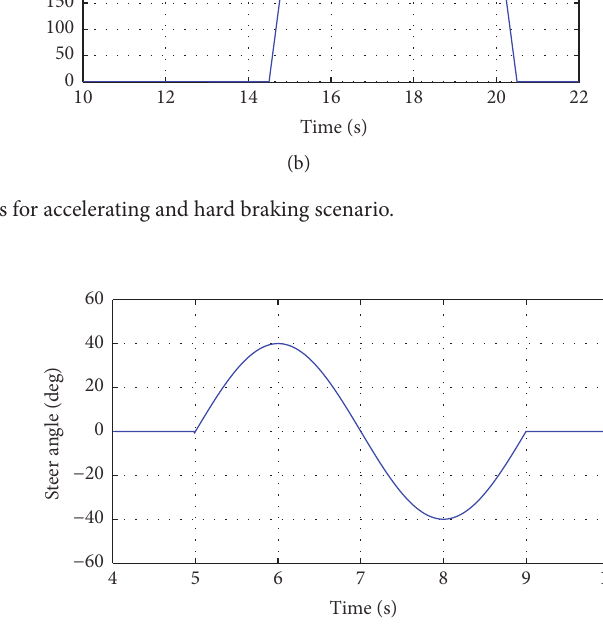
Figure 12: Sinusoidal steer angle used to validate SBVDM.